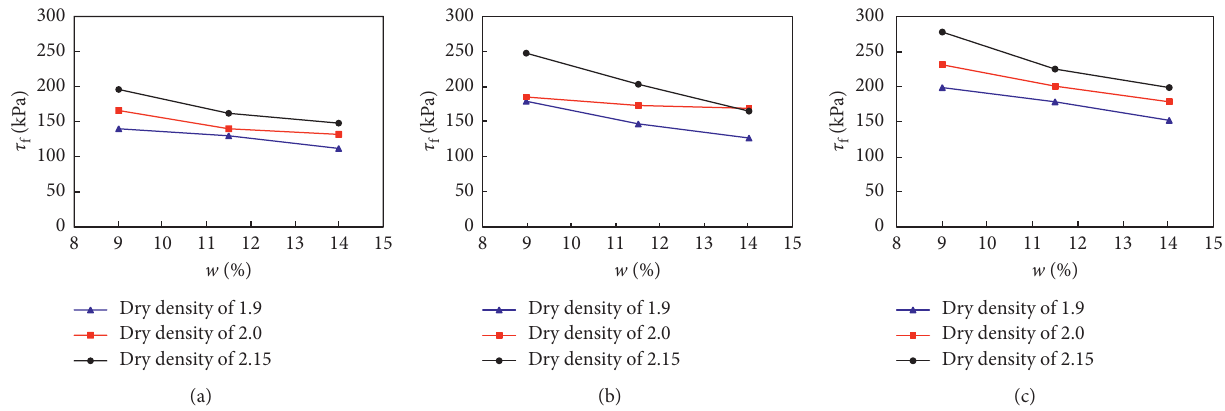
Figure 8: Variations of shear strength ( τ